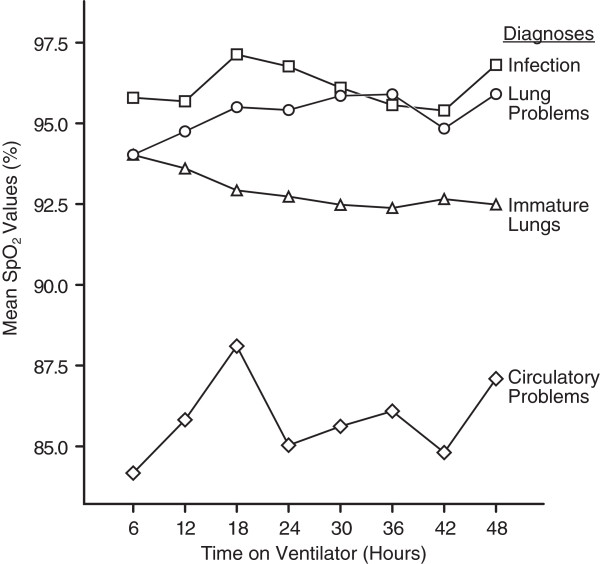
Mean SpO2 trends by diagnosis.